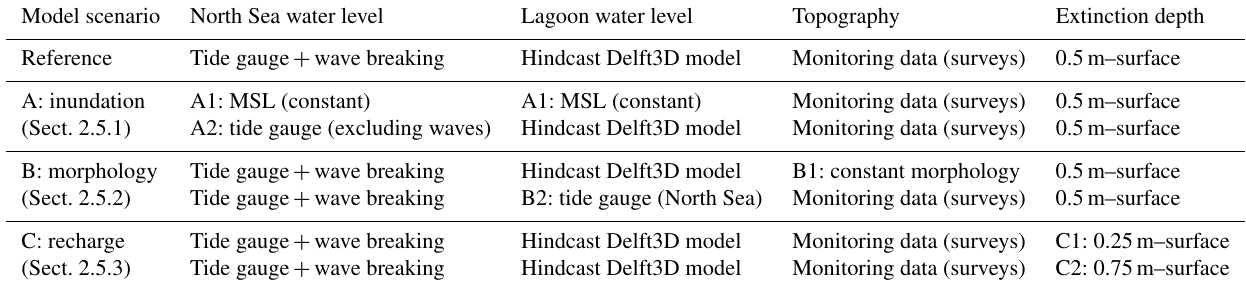
Table 2. Summary of model